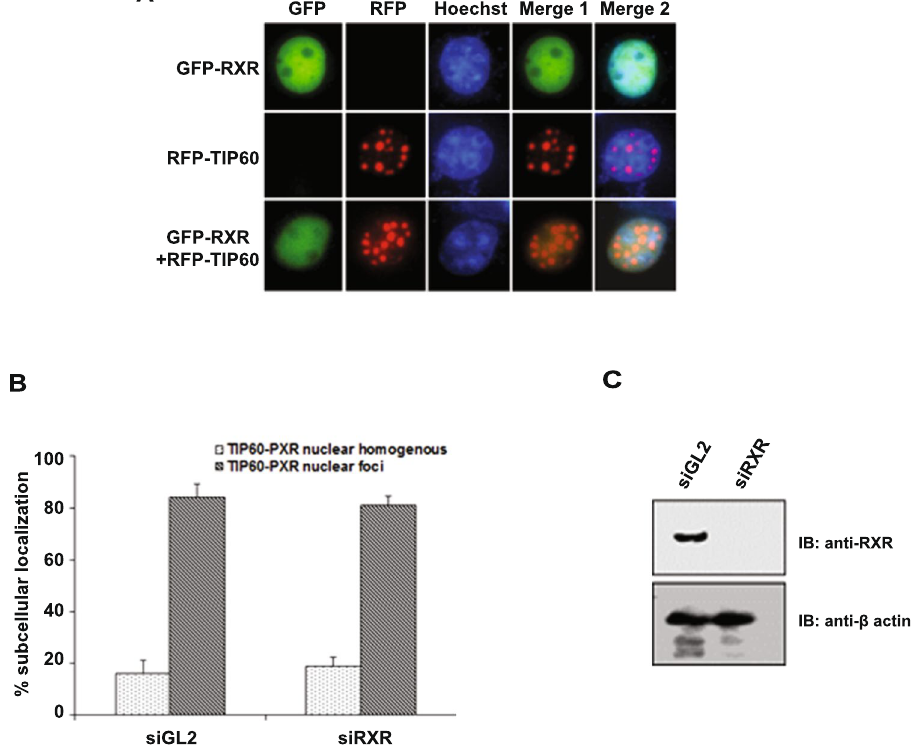
Figure 5. RXR does not form foci with TIP60. ( A ) Cos-1 cells were transfected with GFP-RXR α or RFP-TIP60 alone or together and live cell imaging was performed to monitor their intracellular localization. ( B ) RXR knockdown does not affect TIP60-PXR complex formation. Cos-1 cells were transfected with siGL2 (control) or siRXR α followed by RFP-TIP60 and GFP-PXR plasmids transfection. Live cell imaging was performed and at least 100 transfected cells were counted to detect TIP60-PXR foci formation. Graph depict the mean value of three different sets of experiments with ± SD. ( C ) Western blot show the knockdown efficiency of siRNAs used in the experiment. Full-length immunoblot are presented in Supplementary Figure